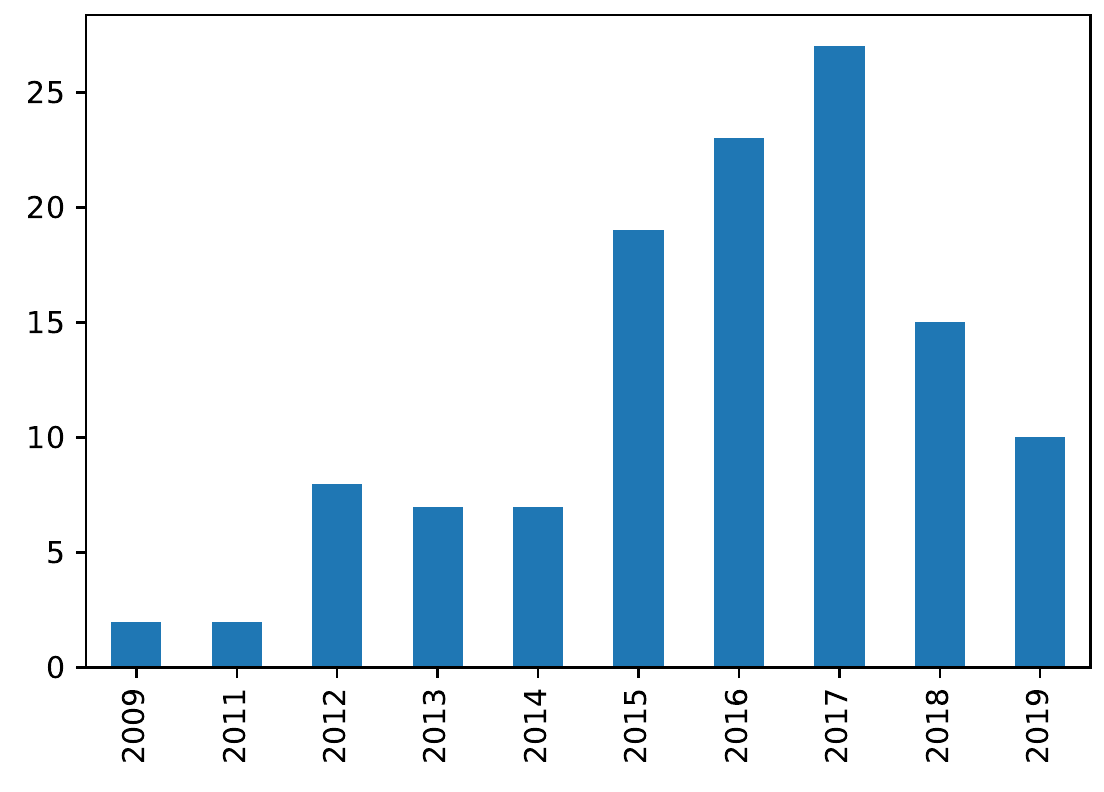
Figure 3. Year distribution of selected papers.